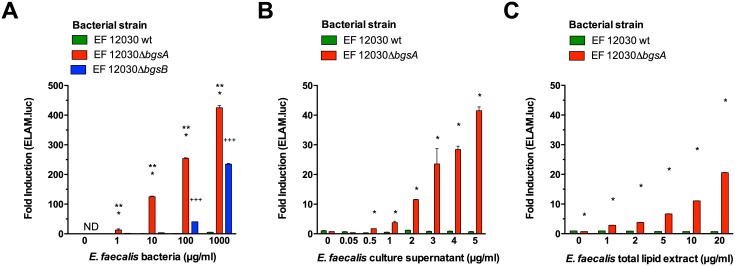
Stimulation of HEK-TLR2 cells transfected with an NF-κB-dependent ELAM-luciferase reporter gene with E. faecalis antigens.HEK cells were stimulated for 6 h with escalating antigen concentrations as indicated, lysed and luciferase activity was determined by luminometry. The concentration of bacterial cells is expressed as dry weight per ml. Fold-induction denotes stimulated versus non-stimulated luciferase activity. Stimulation with whole bacterial cells (A). Stimulation with dialyzed cell-free culture supernatant (B). Stimulation with E. faecalis cell membrane total lipid extracts (C). Data are expressed as mean ± SEM of triplicates. ND = not detected. * p < 0.001 12030 ΔbgsA versus 12030 WT, ** p < 0.001 12030 ΔbgsA versus 12030 ΔbgsB, +++ p < 0.001 12030 ΔbgsB versus 12030 wild type by 2-way ANOVA with Bonferroni post-test for pairwise comparisons.